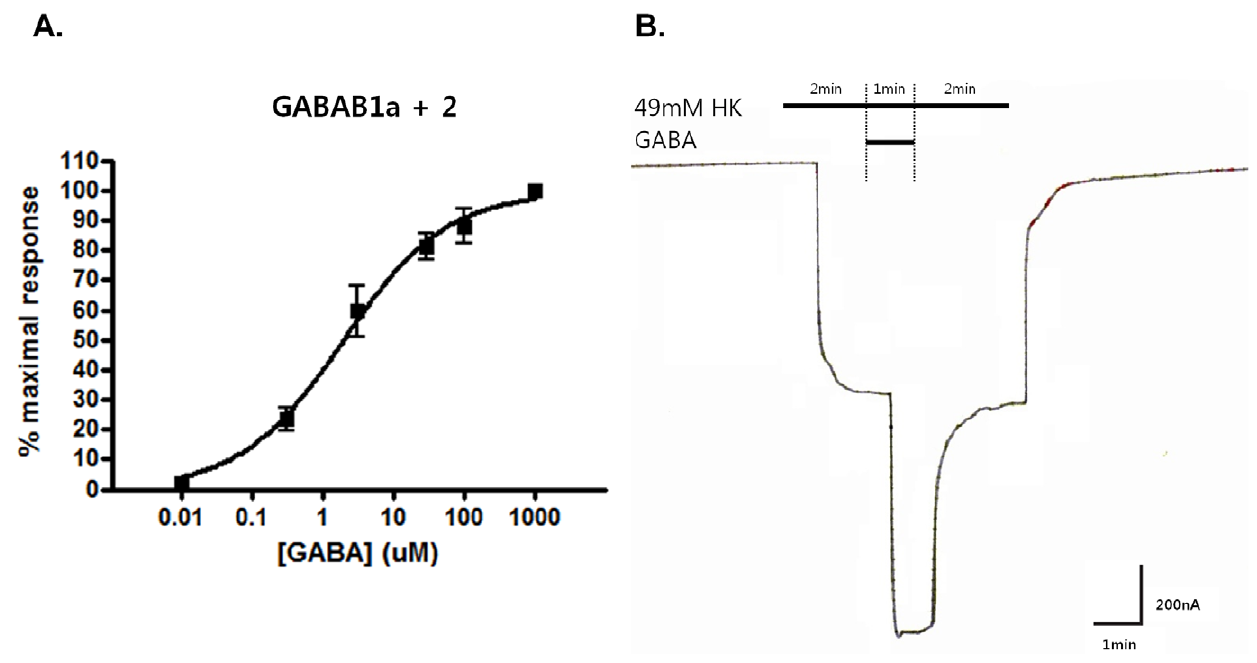
Figure 5. GABAB1a/2 concentration response curve. A. cDNA and cRNA double injections were performed. For cDNAs, both GABAB1a and GABAB2 were injected into the nucleus of Xenopus oocytes. GIRK1 and GIRK2 cRNAs were also injected into the cytosol of the same oocytes. Current response of GABAB receptor and GIRK expressing oocytes were measured by two-electrode voltage clamp. 1 mM GABA was the maximum response concentration; EC 50 was 1.9 uM; Hill slope was 0.59. B. For GABAB1a/2 concentration response curve measurement, GABA dissolved in 49 mM HK was applied for 1 min following a 2 min 49 mM HK application. After 2 additional min of 49 mM HK application, a 20 min wash with ND96 was